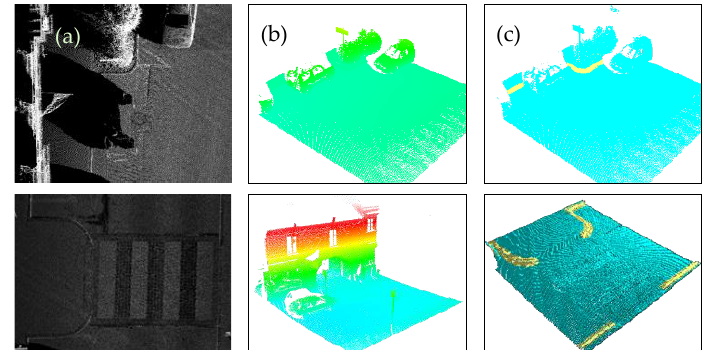
Figure 13. Details of Test Site 2. For each detail, a plan view of the intensity Lidar data ( a ), the original point cloud ( b ), and the result of the proposed method are shown with the curbs in yellow and the background in blue ( c ).